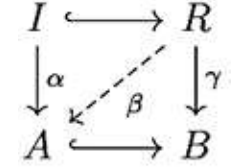
Diagram 7: A is sps-pure sub-module in B